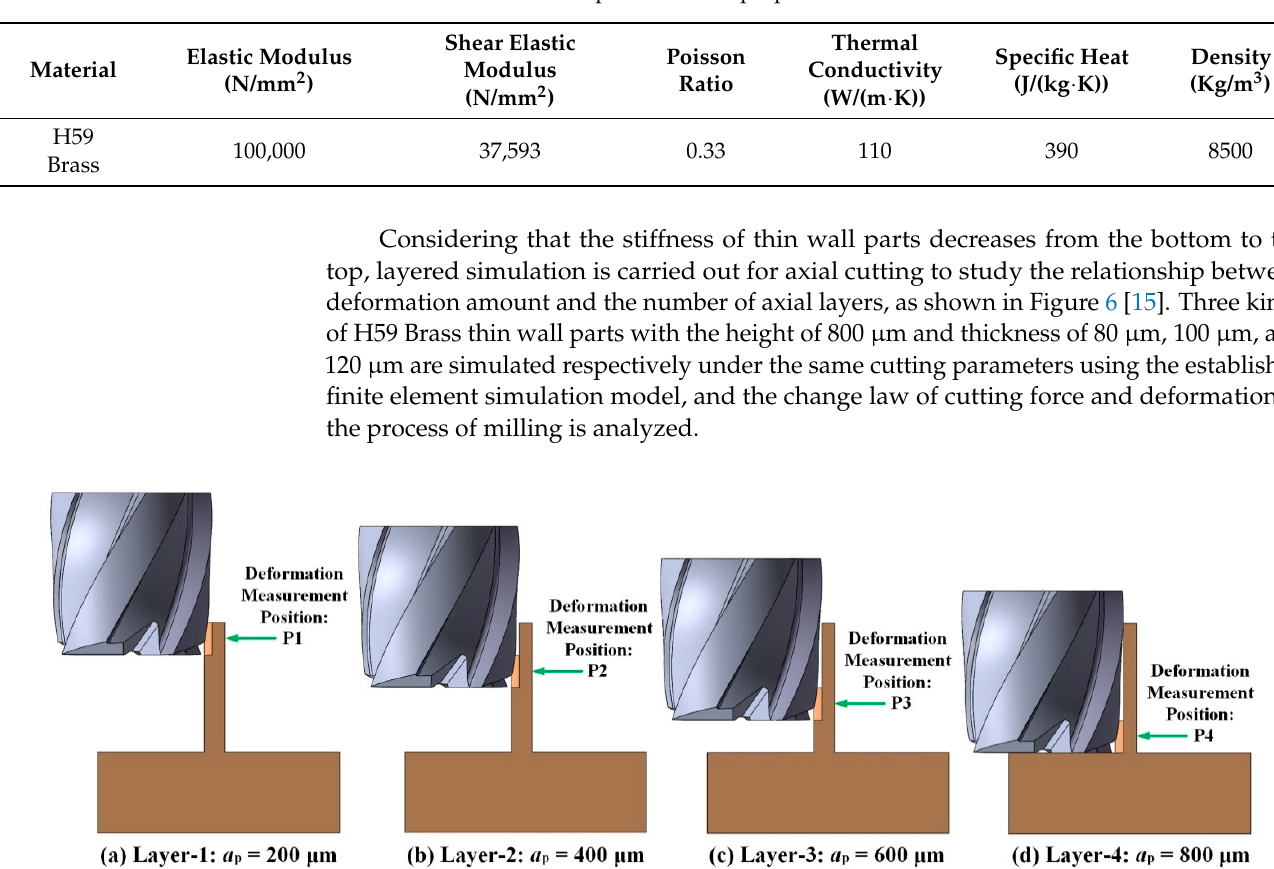
Figure 6. Thin wall deformation measurement by layered milling. ( a ) Layer-1; ( b ) Layer-2; ( c ) Layer-3; ( d ) Layer-4. Table 1. Micro milling cutter properties.